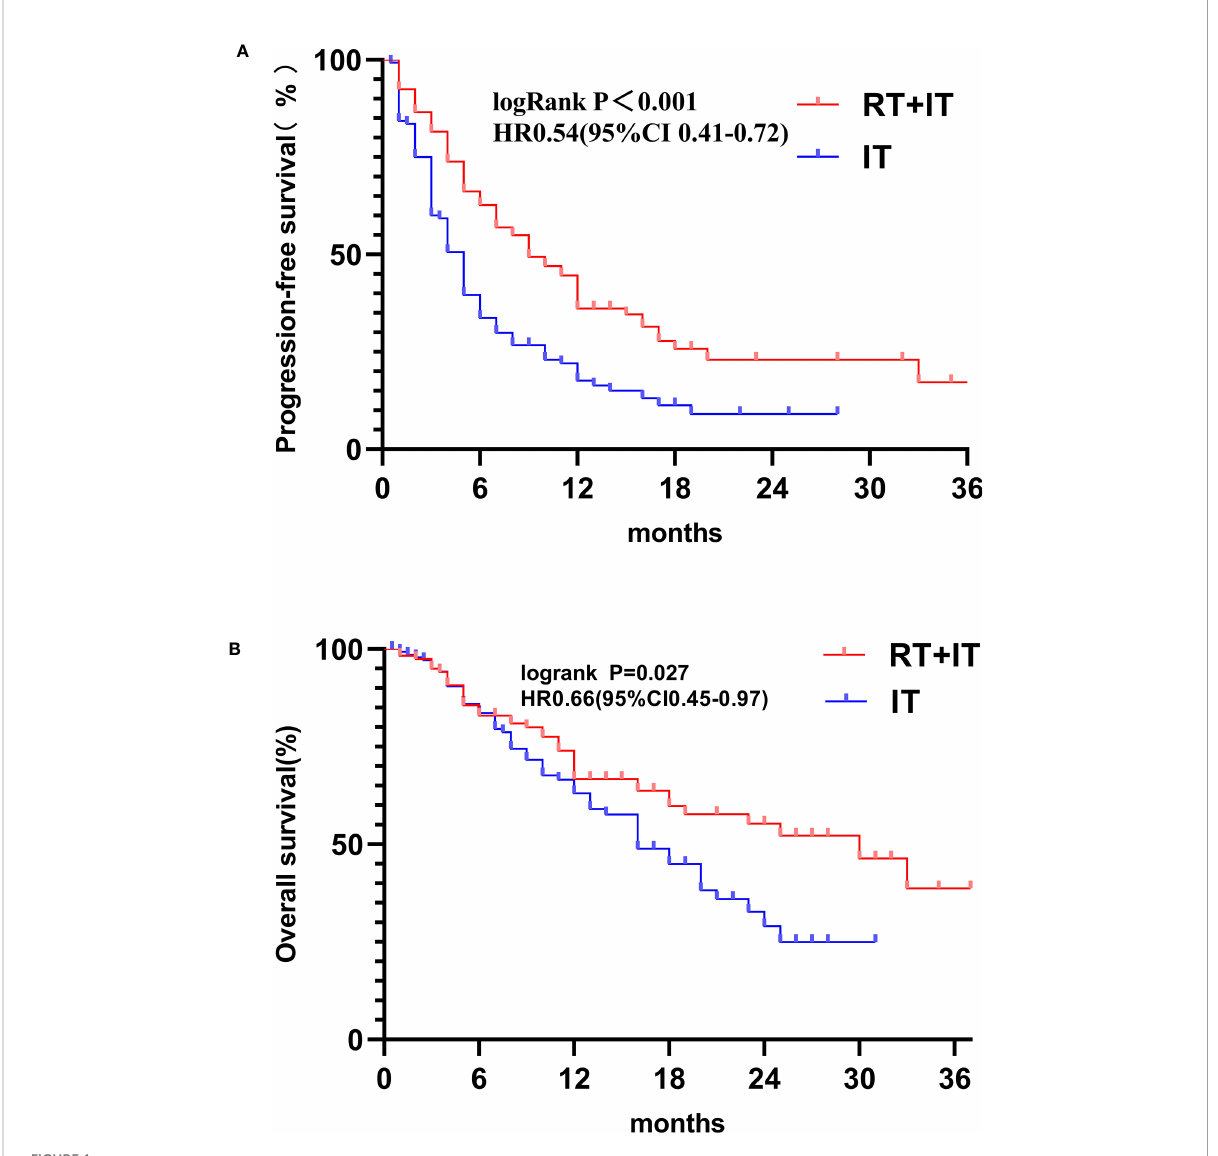
FIGURE 1 Kaplan-Meier analysis of progression-free survival (A) and overall survival (B)